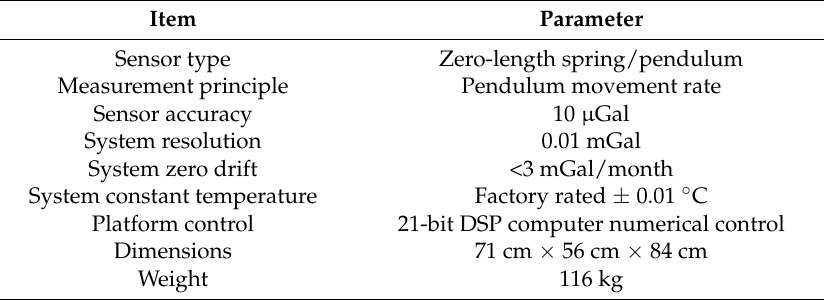
Figure 2. LaCoste and Romberg S-129 gravimeter. Table 1. Basic parameters of the L and R S-129 gravimetry system.